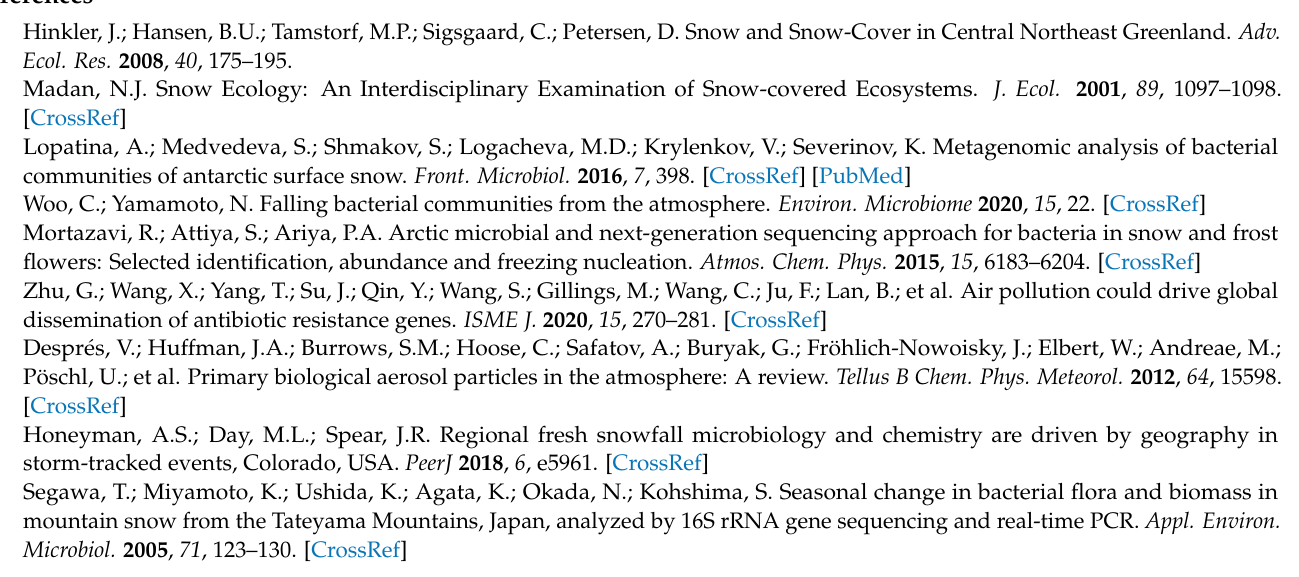
phylum and genera in double pie chart; Figure S3: Alpha diversity indices of the 16S in fresh snowfall samples; Figure S4: Average composition of fungal phylum and genera presented in double pie chart; Figure S5: Alpha diversity indices of the ITS in fresh snowfall